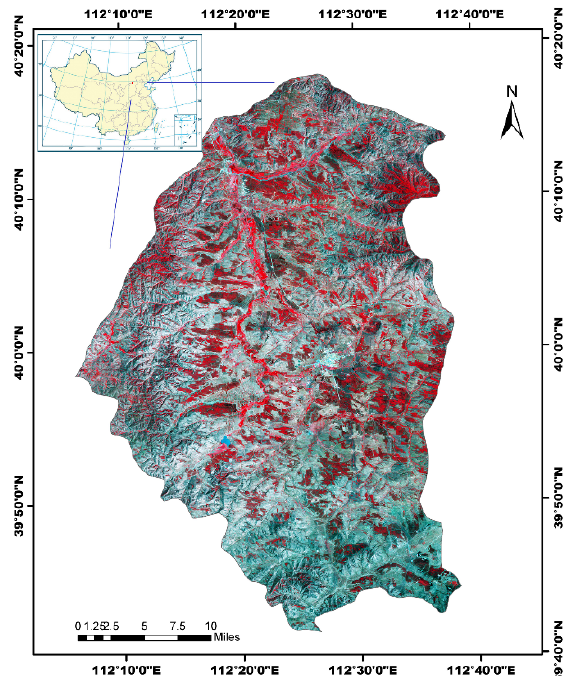
Figure 1. Youyu county in Shanxi Province, China. The imagery represent a false-color composite of one Landsat image acquired on 10 July 2009.